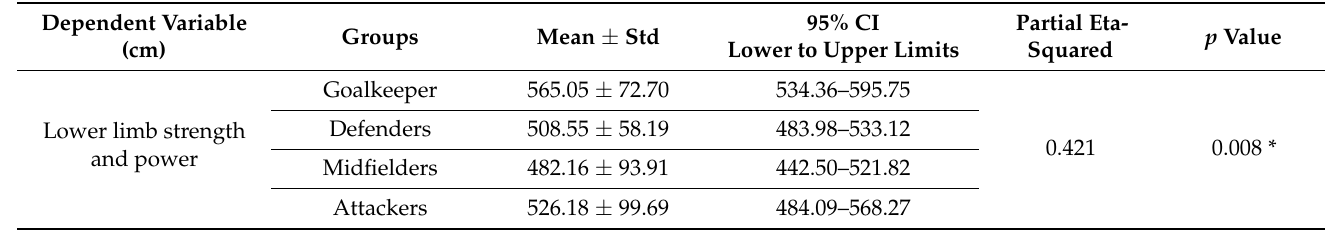
Table 6. Statistical analysis of variance of lower limb strength and power values of soccer players for their playing position.